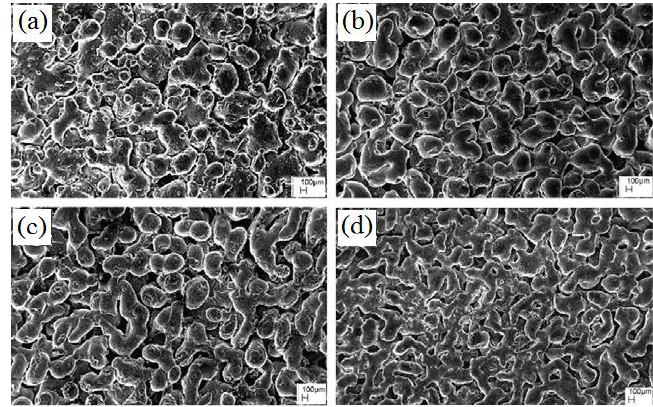
Figure 9. The surface morphology of ( a ) pure Al-7Si-0.3Mg as well as SiC-reinforced Al-7Si-0.3Mg matrix composites with ( b ) 5, ( c ) 10, and ( d ) 20 vol.% SiC fabricated by the selective laser sintering (SLS) process [92].